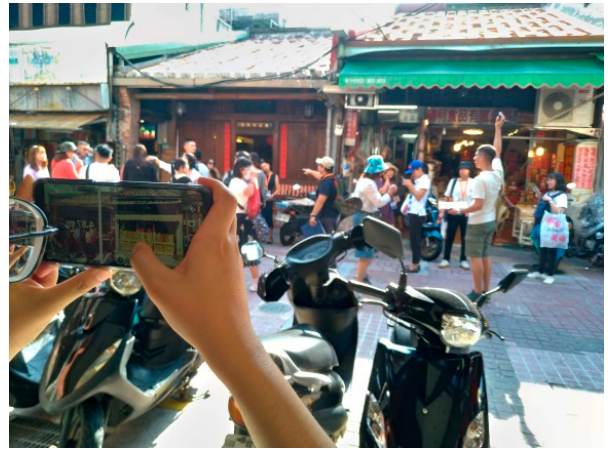
Figure 16. One of the factors that affected the situated comparison by interference of pedestrians or vehicles.